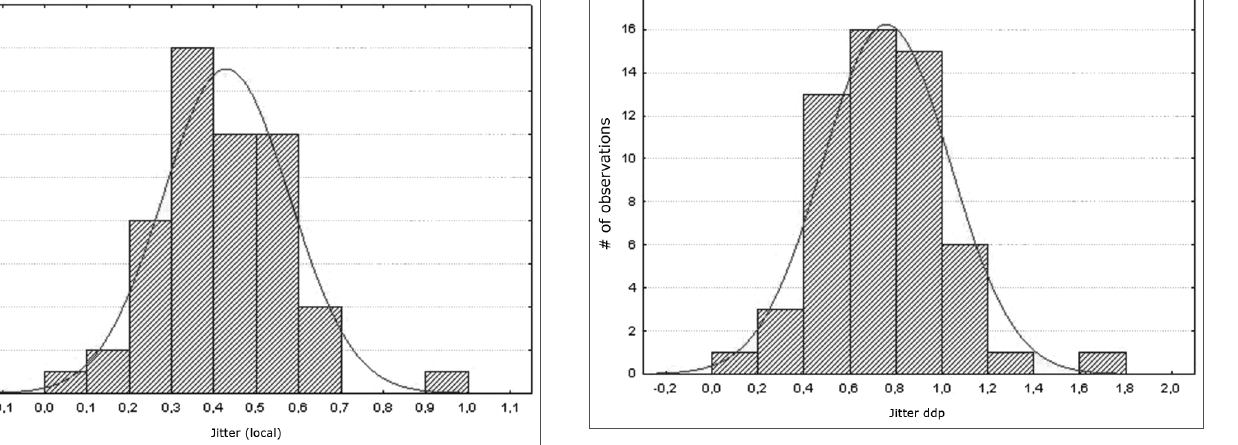
Figure 5. Normal distribution of jitter (ddp) - Histogram